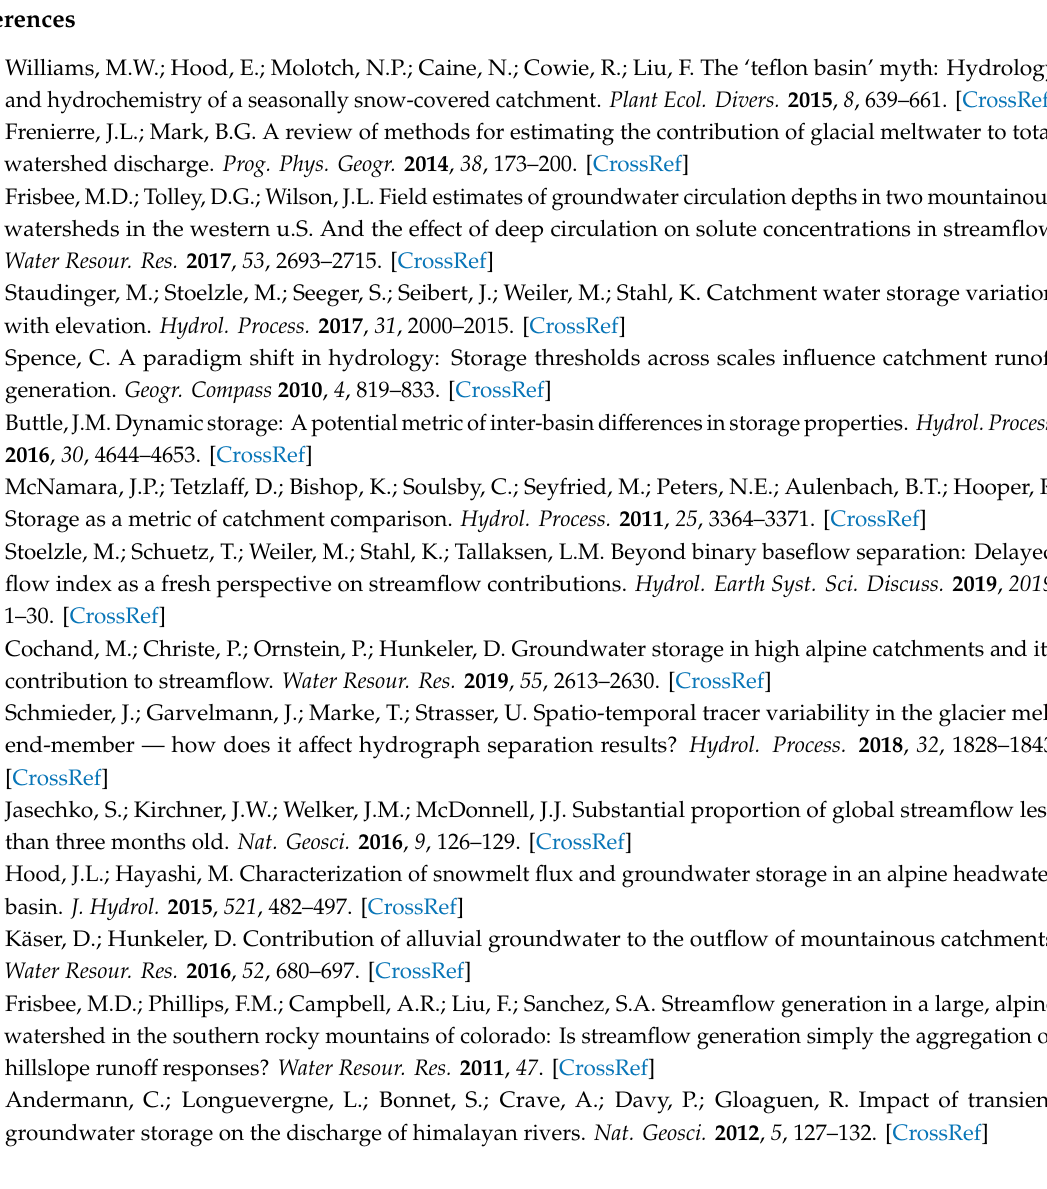
Table S1: ANIP station overview, Table S2: Monthly isotopic lapse rates, Table S3: Input data as used for TRANSEP, Table S4: Fit statistics and regression coefficients of the sine wave approach for estimating the young water